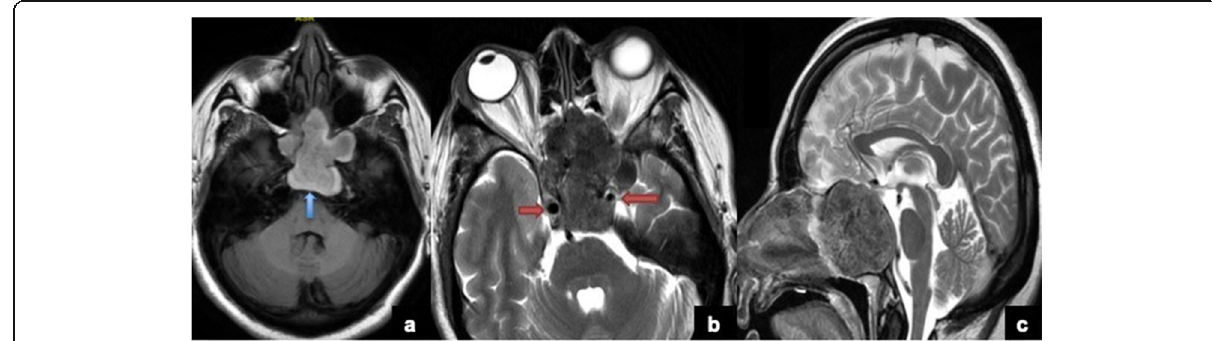
Fig. 2 a T1-weighted axial MRI image shows hyper intense lesion filling the sphenoid sinus extending into adjacent greater wing of sphenoid bone, posterior ethmoid air cells, and clivus (blue arrow). The lesion appears hypo intense/dark on axial T2-weighted image ( b ) and sagittal T2- weighted image ( c ) confirming the proteinaceous content within the sinus. There is extension of lesion into bilateral cavernous sinus with partial